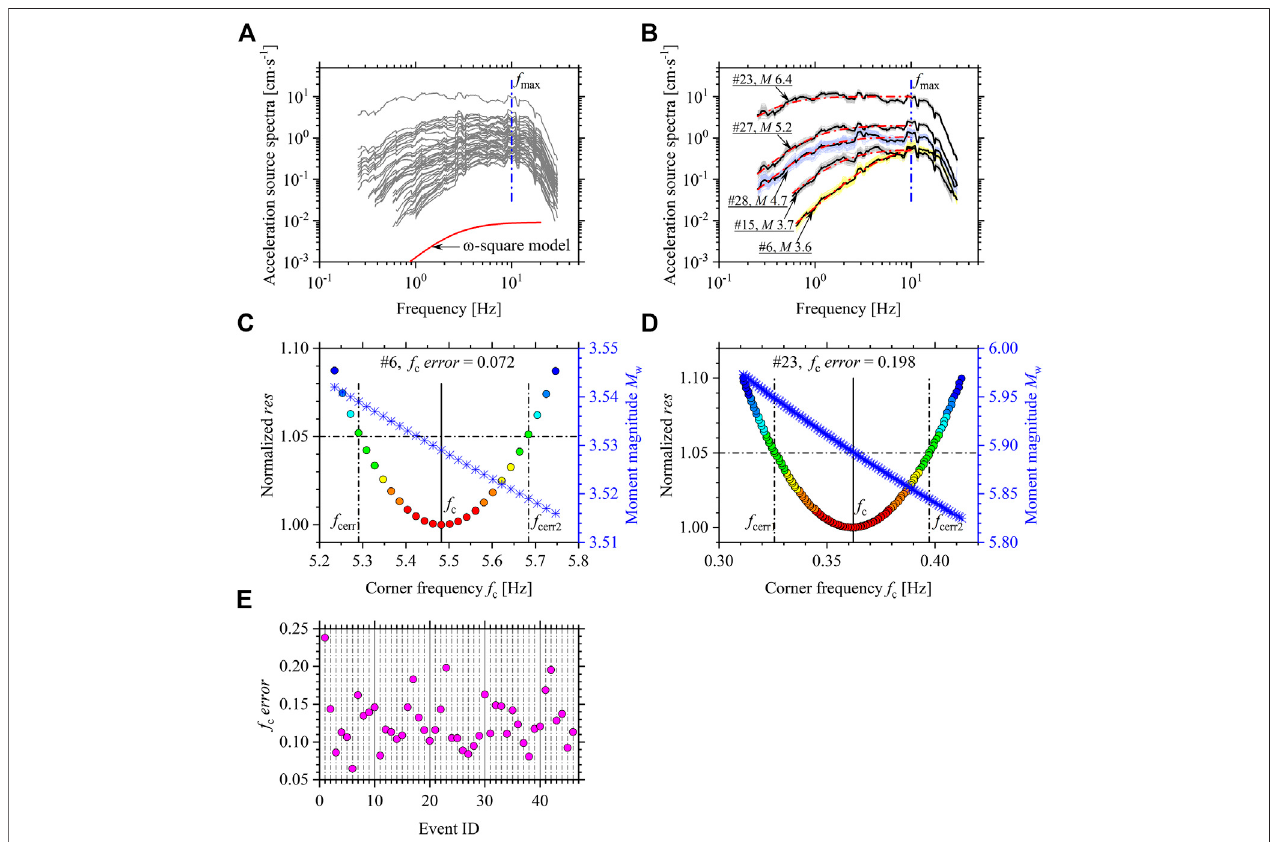
FIGURE6|(A) Invertedaccelerationsourcespectrafortheearthquakesconsidered; (B) theinvertedsourcespectrafrom100bootstrapinversions(gray,lightblue, and lightyellow lines) and thebest- fi ttedtheoreticalsource spectra (reddashed-dottedlines) atfrequenciesbelow10 Hzfor fi ve typical events (#10,20,27,40,and 41). Thedarklinesrepresenttheinvertedsourcespectrausingthewholedataset; (C,D) theparabolashapesforthe res normalizedbytheminimum res correspondingtothe preferred f c against thepossible corner frequencies for#10and 40 events, respectively. Frequenciesat which res exceeds 5%oftheminimum res areregardedas f c uncertainty bounds ( f cerr1 and f cerr2 ) to provide f c error for quantitatively evaluating the parabola shape. The estimated M w - f c pairs (crosses) for the possible f c are also provided; (E) f c error values for the considered events. Event ID is listed in Table 1